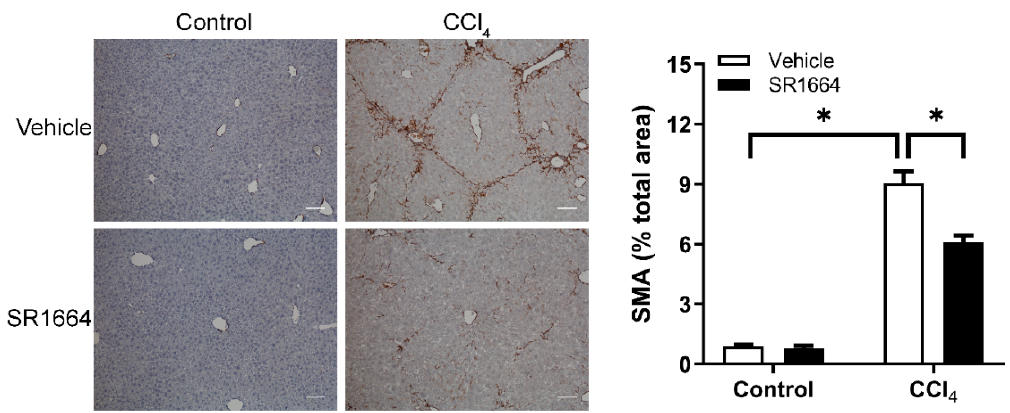
Figure 3. Smooth muscle α -actin (SMA) content in liver from control or fibrotic mice treated with SR1664 or vehicle. Immunohistochemistry for SMA (left panel); quantification of SMA staining intensity (right panel); bar = 200 µm; mean ± S.E.M.; n = 6; * p < 0.05 by ANOVA.